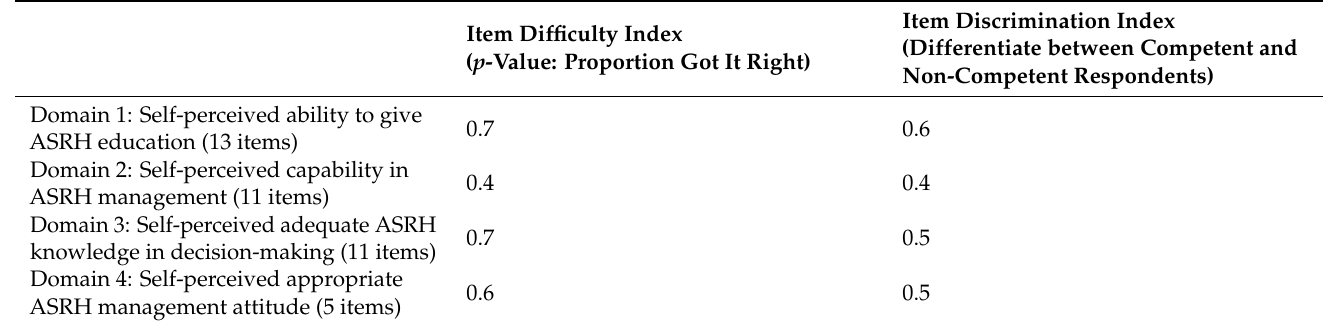
Table 4. Scores of item